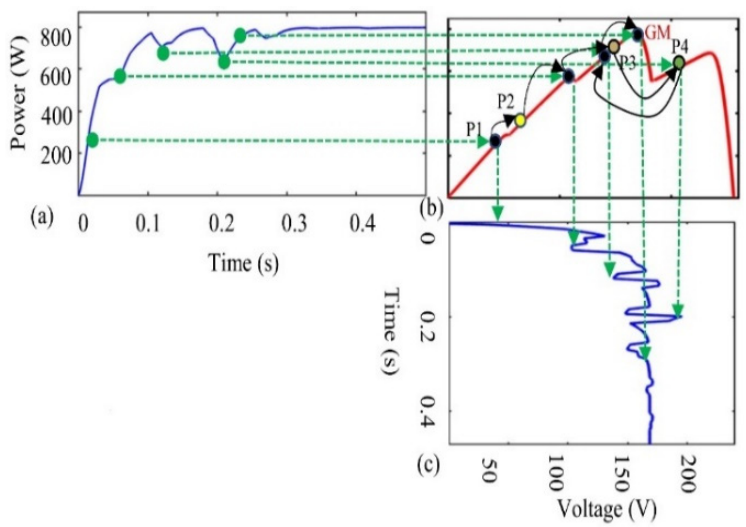
Figure 11. The tracking mechanism of the HOA through P-V curve ( a ) power-time curve, ( b ) GM tracking curve and ( c ) voltage-time curve.